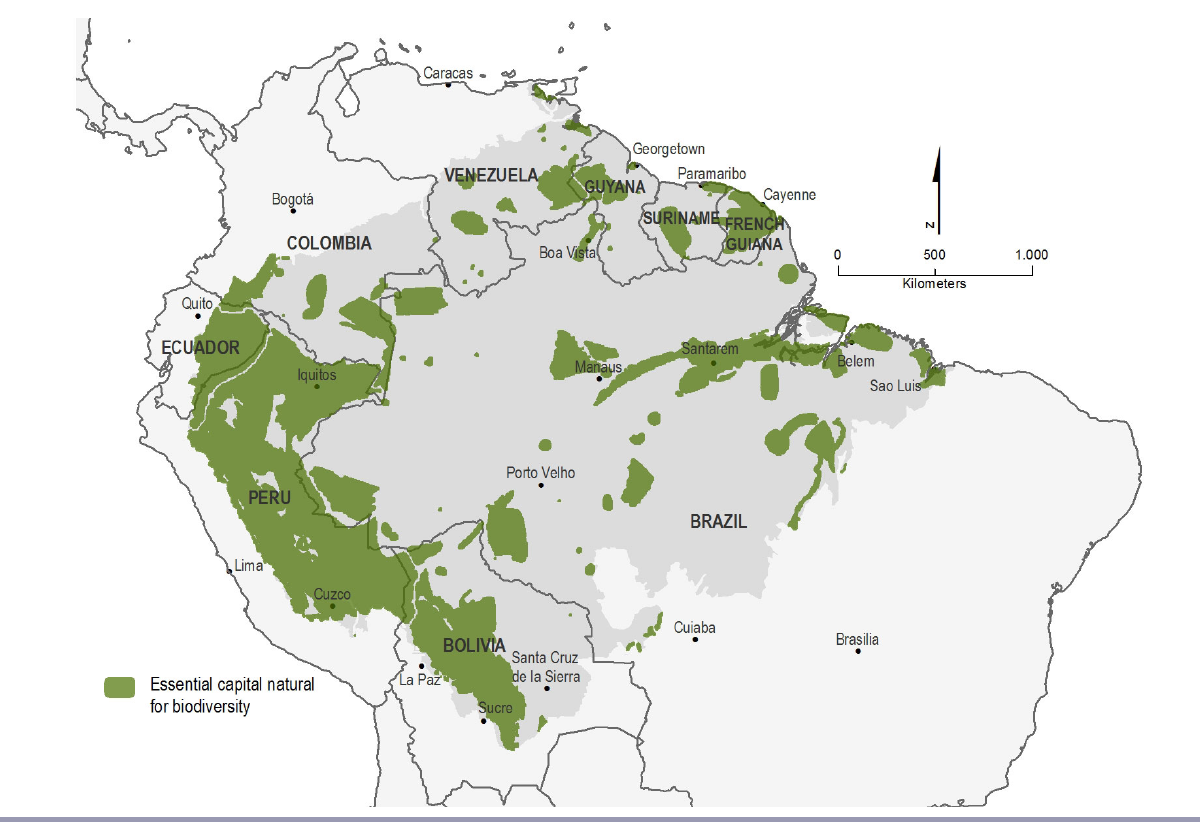
Fig. 4 . Essential natural capital: the areas of the greatest importance regarding endemism evaluated. Source: Modified from Neugarten et al.